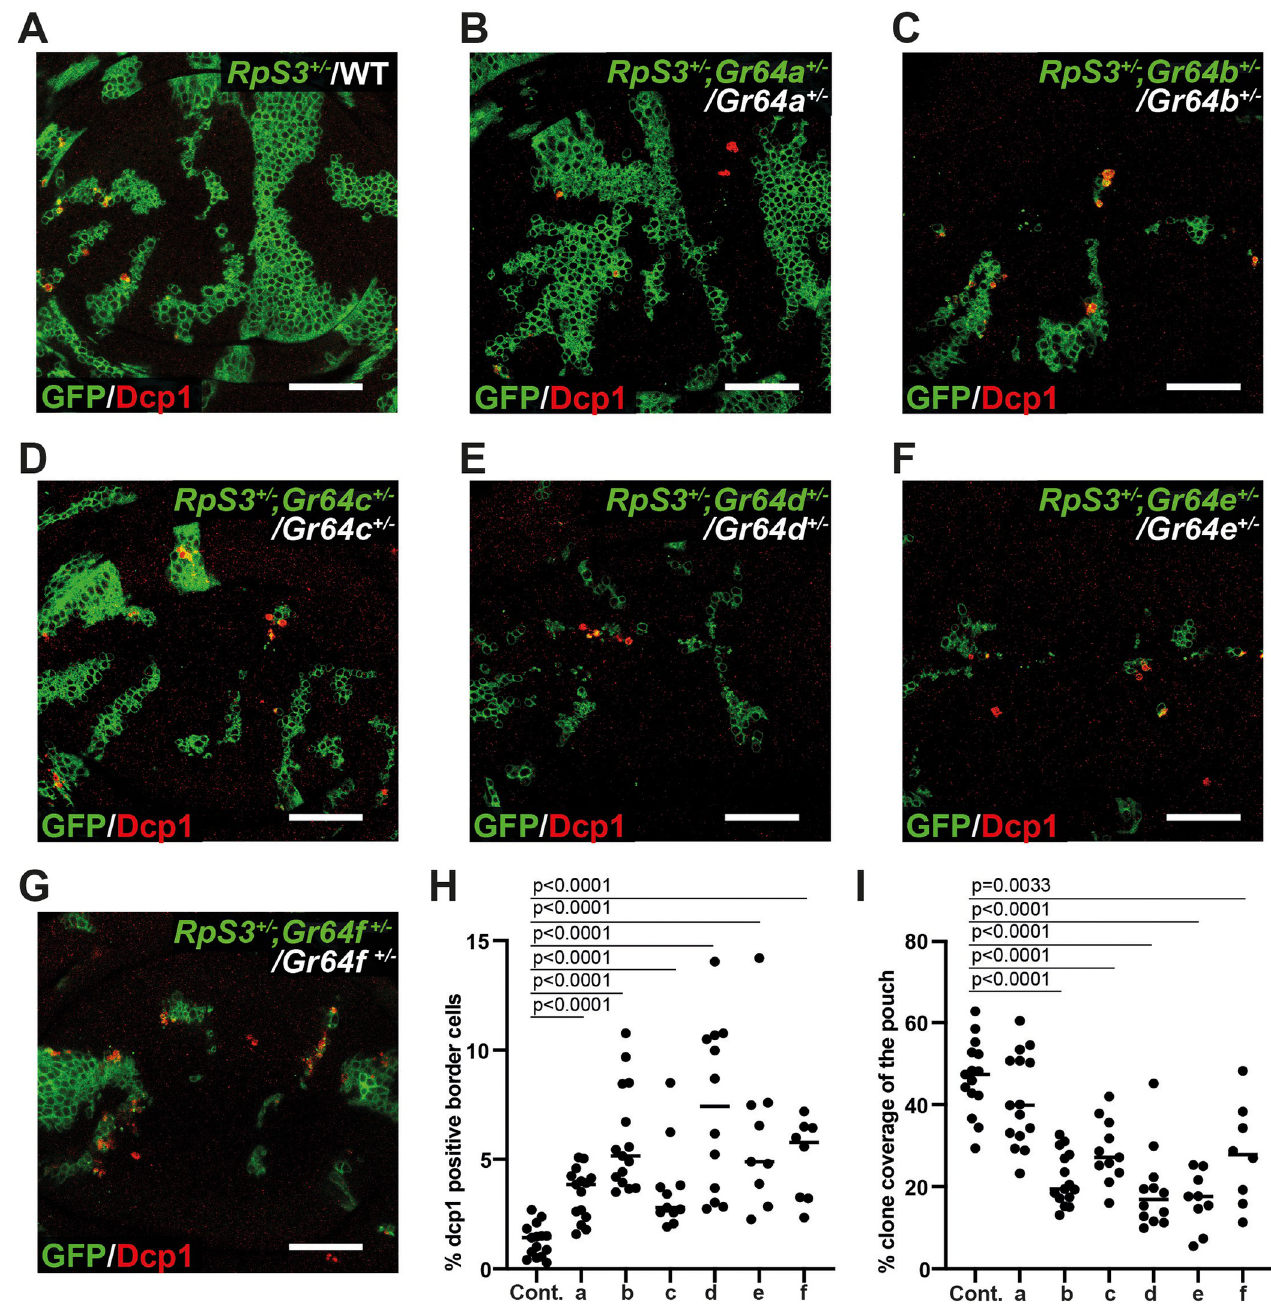
Fig 2. H AU : PleaseaddscalebarsinFigs 2 (cid:0) 4 : eterozygosity at Gr64 loci exacerbates competitive RpS3 +/- loser cell elimination. ( A – G ) Representative images of wing discs containing RpS3 +/- loser cells (green) competing against wild-type winners (unlabelled) and stained for cleaved-Dcp1 (red). RpS3 +/- clones were generated in a wild-type background ( A ) or in wing discs heterozygous for any one of the Gr64 genes a through f (mutations used were Gr64a GAL4 , Gr64b LEXA , Gr64c LEXA , Gr64d 1 , Gr64e LEXA , and Gr64f LEXA ) ( B – G ). ( H ) Quantification of the percentage of cells undergoing apoptosis at loser clone borders in wing discs of genotypes as shown in ( A – G ).Statistics reflect multiple logistic regression across 3 replicates (details provided in Materials and methods). ( I ) Quantification of loser cell growth in wing discs of the genotypes shown in ( A – G ),as measured by the percent loser clone coverage of the pouch. Statistics reflect Student t test with FDR p-correction. n control = 16, n Gr64aGAL4 = 15, n Gr64bLEXA = 15, n Gr64cLEXA = 11, n Gr64d[1] = 12, n Gr64eLEXA = 9, n Gr64fLEXA = 8. For all quantifications, the horizontal line indicates the mean. Scale bars correspond to 50 μ m. Numerical data can be found in the “Fig 2” sheet of S1 Data. FDR, false discovery rate; Gr64, Gustatory Receptor 64; Rp, ribosome